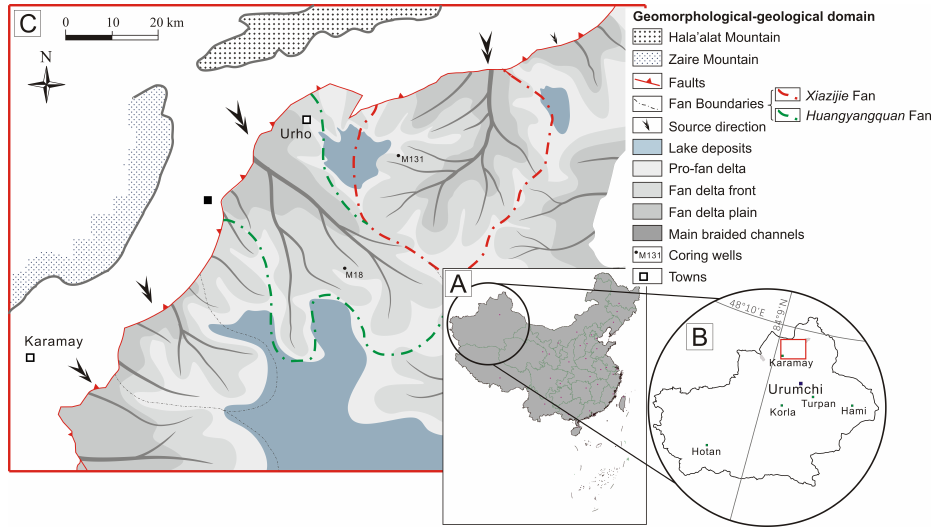
Figure 1. Location of the study area (modified after Tao et al. [25]). ( A ) Large-scale map of Xingjiang Province, China. ( B ) Work location in northern Xinjiang Province. ( C ) Detailed map with typical coring well locations and the approximate scope of ancient fan deposits (including alluvial fans and fan